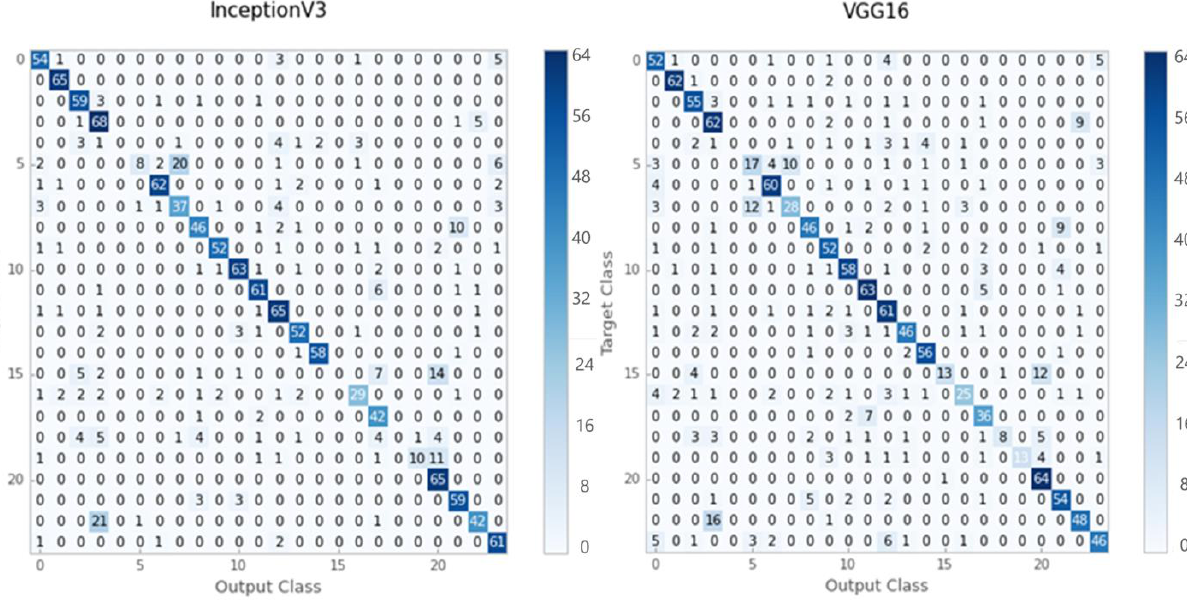
Figure 4. The confusion matrixes for the Inception-V3 and VGG16 pre-trained models. In the grayscale test dataset, the Inception-V3 model correctly classified 1058 out of 1325 images, while the VGG16 model correctly classified just 1025 out of 1325 images. Table 1 shows the accuracy, recall, and F1-score values of the Inception-V3 and VGG16 models for grayscale test-set images. Inception-V3 yielded 80 percent for the average pre- cision, recall, and F1 score for grayscale histopathology images. On the other hand, VGG16 achieved 77 percent using the same assessment criterion.